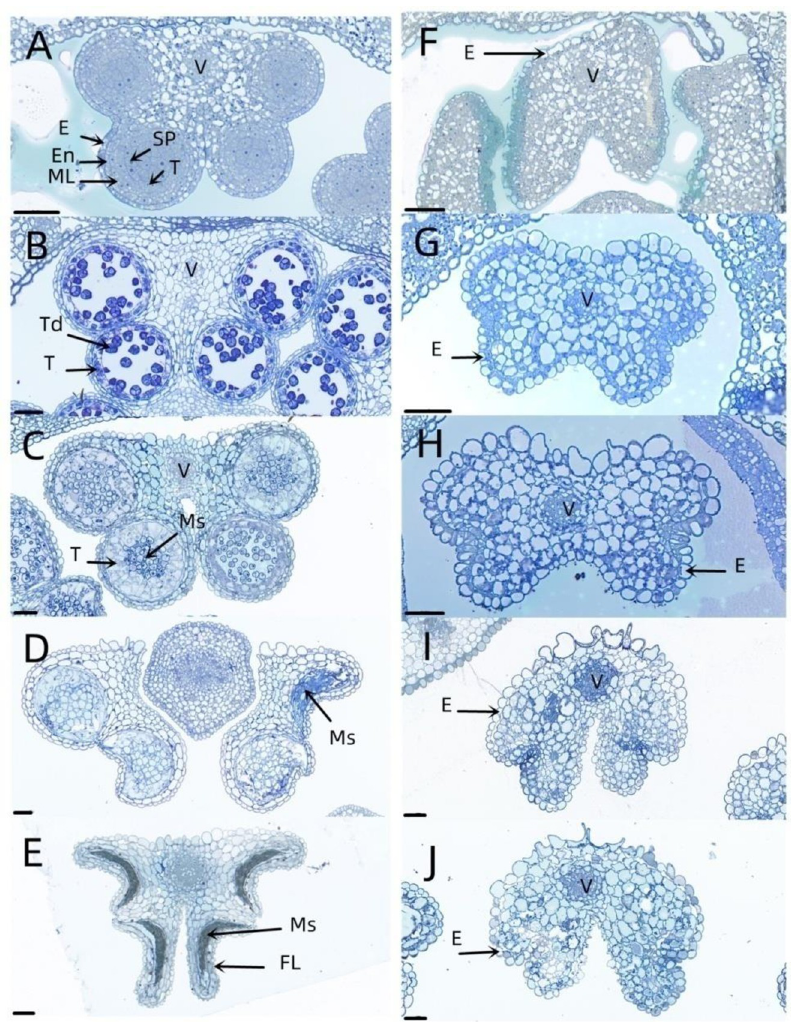
Fig 2. Semi-thin sections to observe anter of 1258A (A–E) and P5A (F–J) during pollen develop. (A, F) Sporogenous cell differentiation stage; (B, G) microspore tetrad stage; (C, H) single nucleus pollen grain stage; (D, I) mature pollen grain stage; (E, J) pollen release period. E, epidermis; En, endothecium; FL, fibrous layer; ML, middle layer; SP, sporogenous cell; T, tapetum; Td, Tetrad; Ms, microspore; V, vascular region. Bar = 50 μ